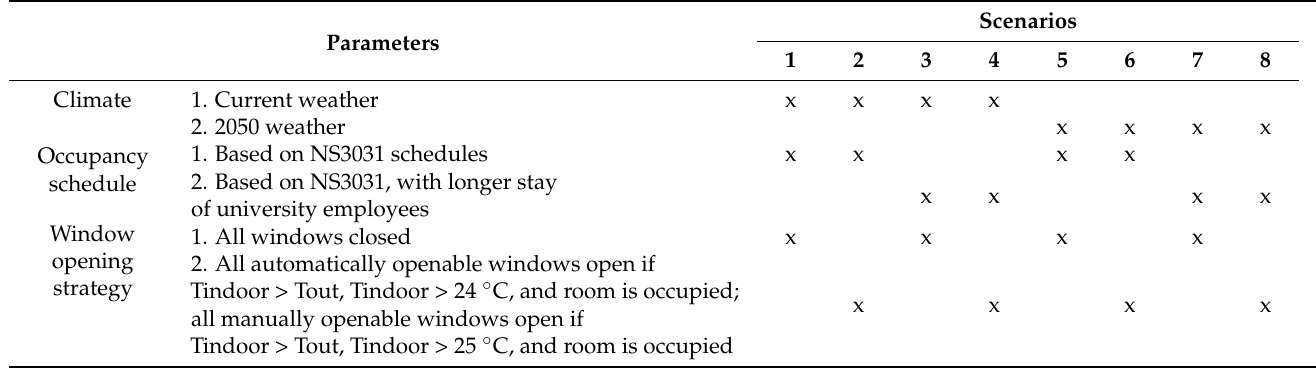
Table 5. Summary of the main parameters for all the scenarios analysed.